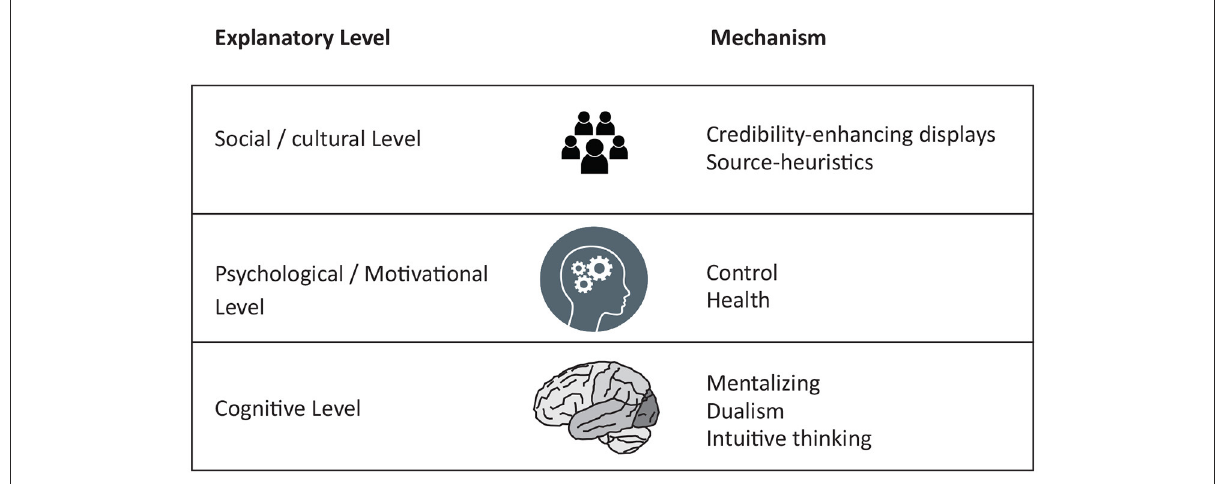
FIGURE1 Overview of the different explanatory levels (Left) and the hypothesized mechanisms (Right) that have been proposed to account for the emergence and proliferation of supernatural